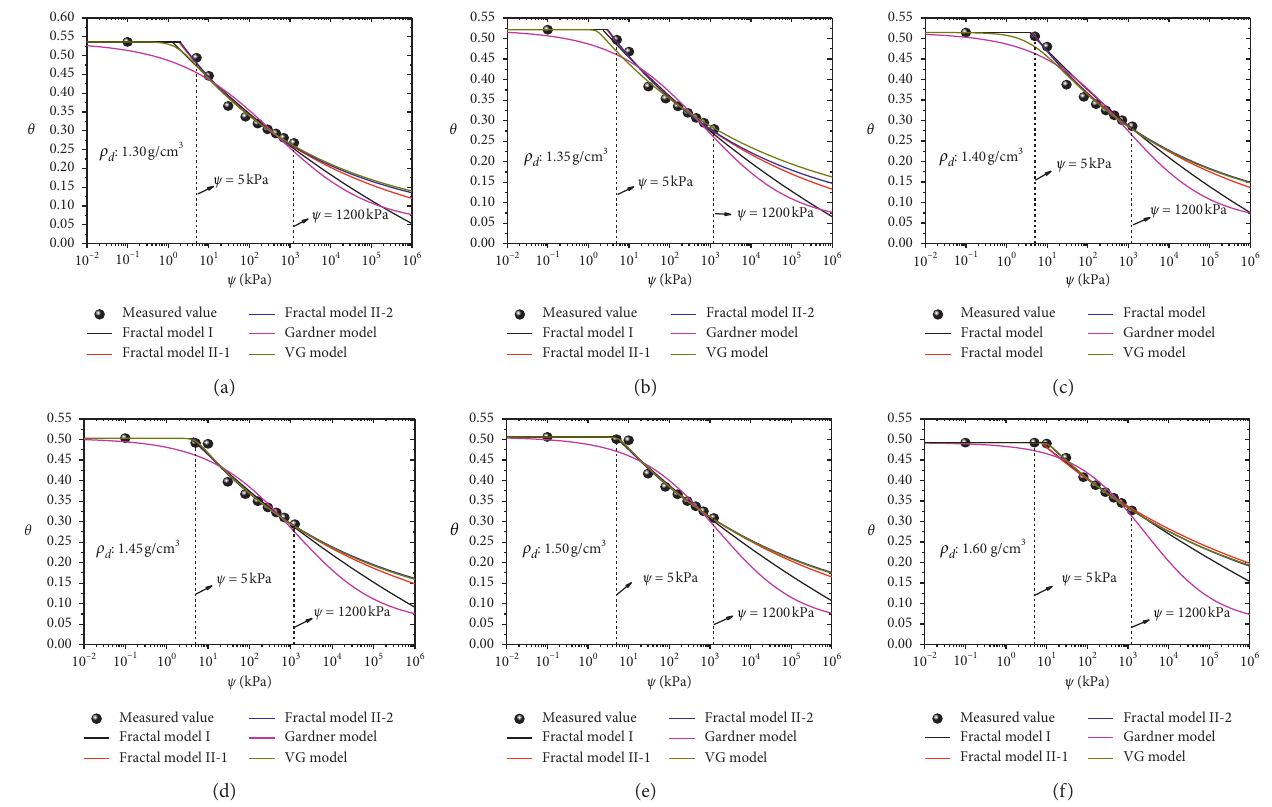
Figure 4: Fitting diagram of SWCC with initial different dry